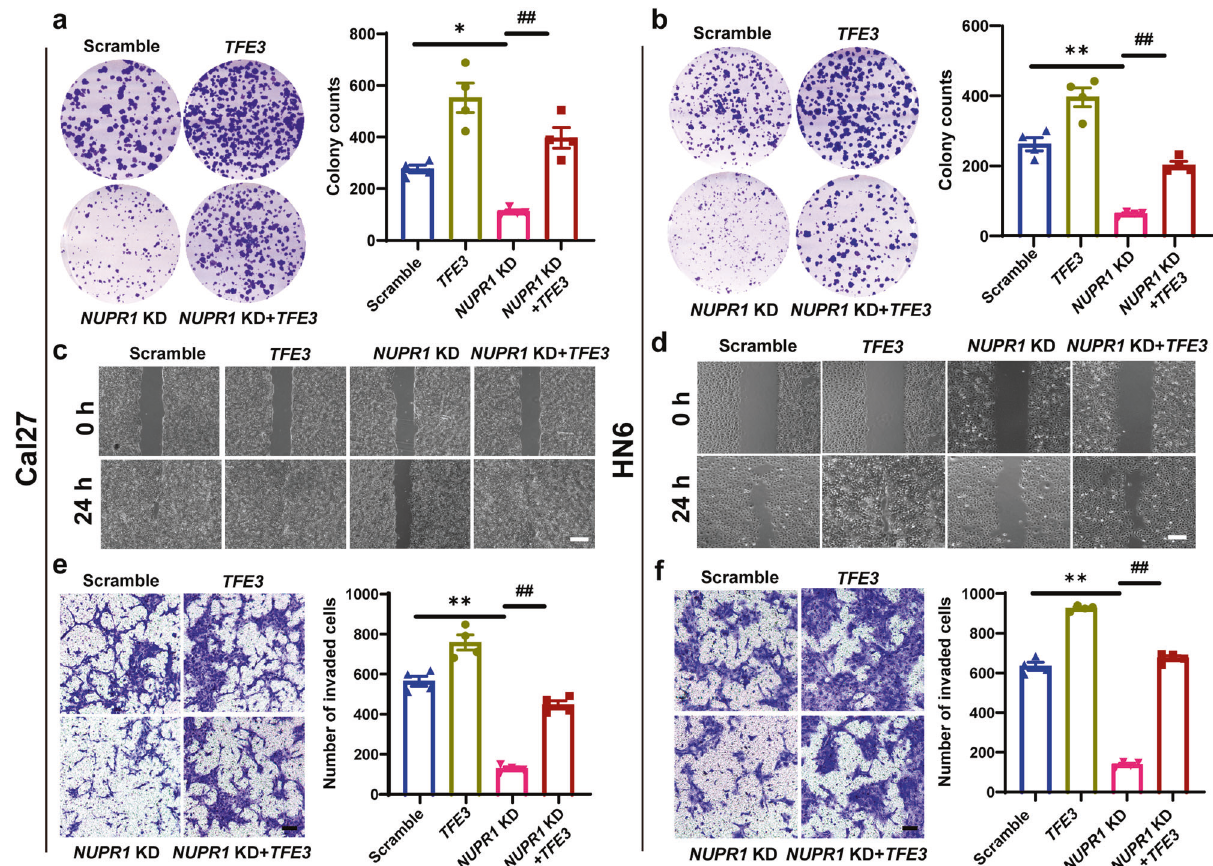
Fig. 5 TFE3 overexpression antagonised the NUPR1 KD-induced inhibition of OSCC cell proliferation and metastasis. a , b The colony formation results for NUPR1 KD or scrambled Cal27 and HN6 cells transfected with TFE3 plasmid or a control plasmid; n = 4. c , d The migration results for of NUPR1 KD or scrambled Cal27 and HN6 cells transfected with TFE3 plasmid or a control plasmid; Scale bar: 100 μ m. e , f The invasion results for NUPR1 KD or scrambled Cal27 and HN6 cells transfected with TFE3 plasmid or a control plasmid. Scale bar = 80 μ m; magni fi cation; n = 4; 40×; * P < 0.05, ** P < 0.01 vs. the scrambled group, ## P < 0.01 vs. the NUPR1 KD